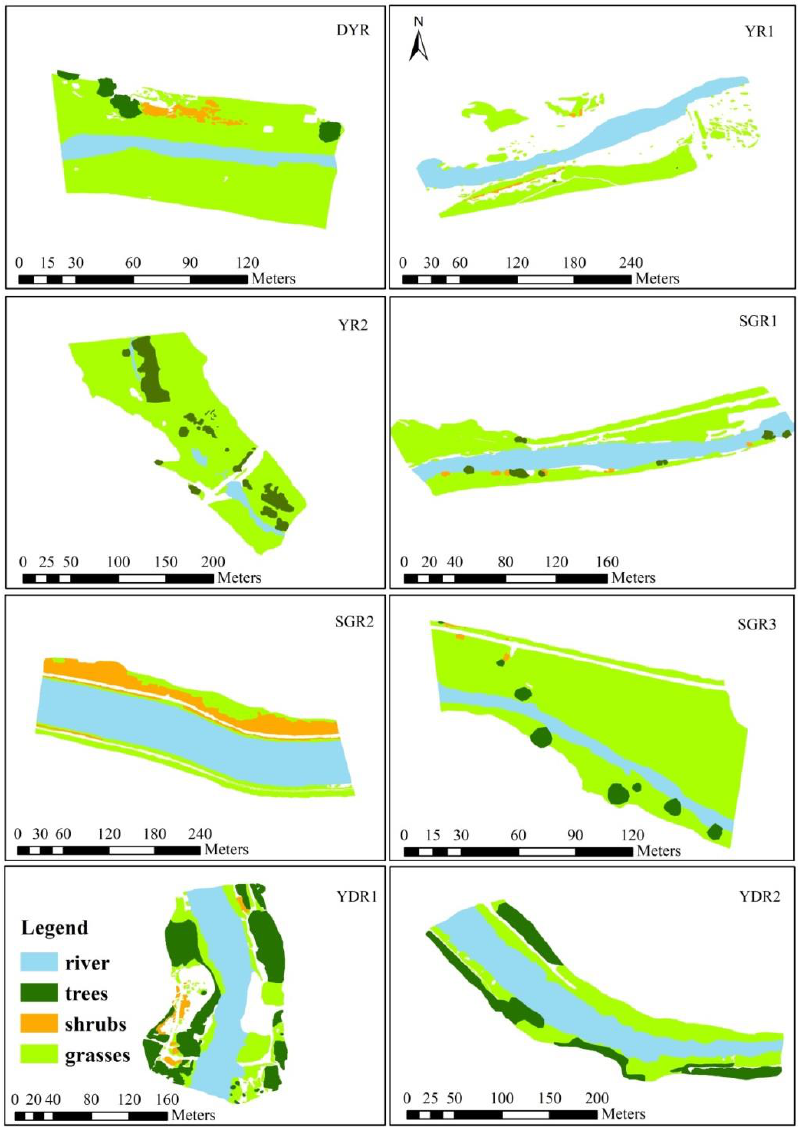
Figure 3. The distribution of the different plant life forms in the riparian zones of the eight selected reaches. Table 2. The proportion of different vegetation coverage grades in the selected eight reaches.